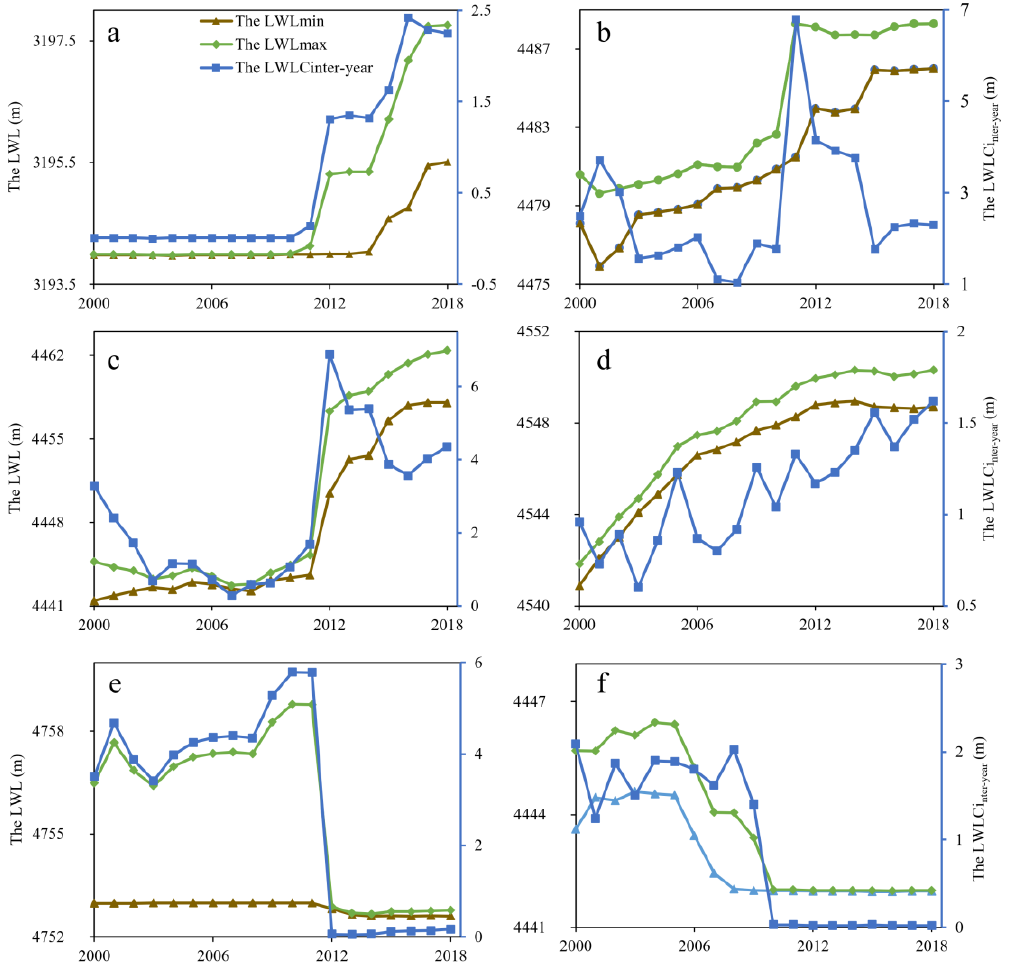
Figure 5. ( a ) the LWLC of Qinghai Lake; ( b ) the LWLC of Kusai Lake; ( c ) the LWLC of Salt Lake; ( d ) the LWLC of Selinco; ( e ) the LWLC of Zhuonai Lake; ( f ) the LWLC of Yamdrok Lake.